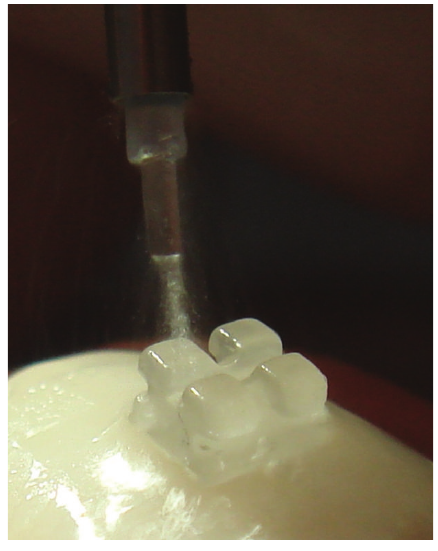
Figure 2: Application of the laser